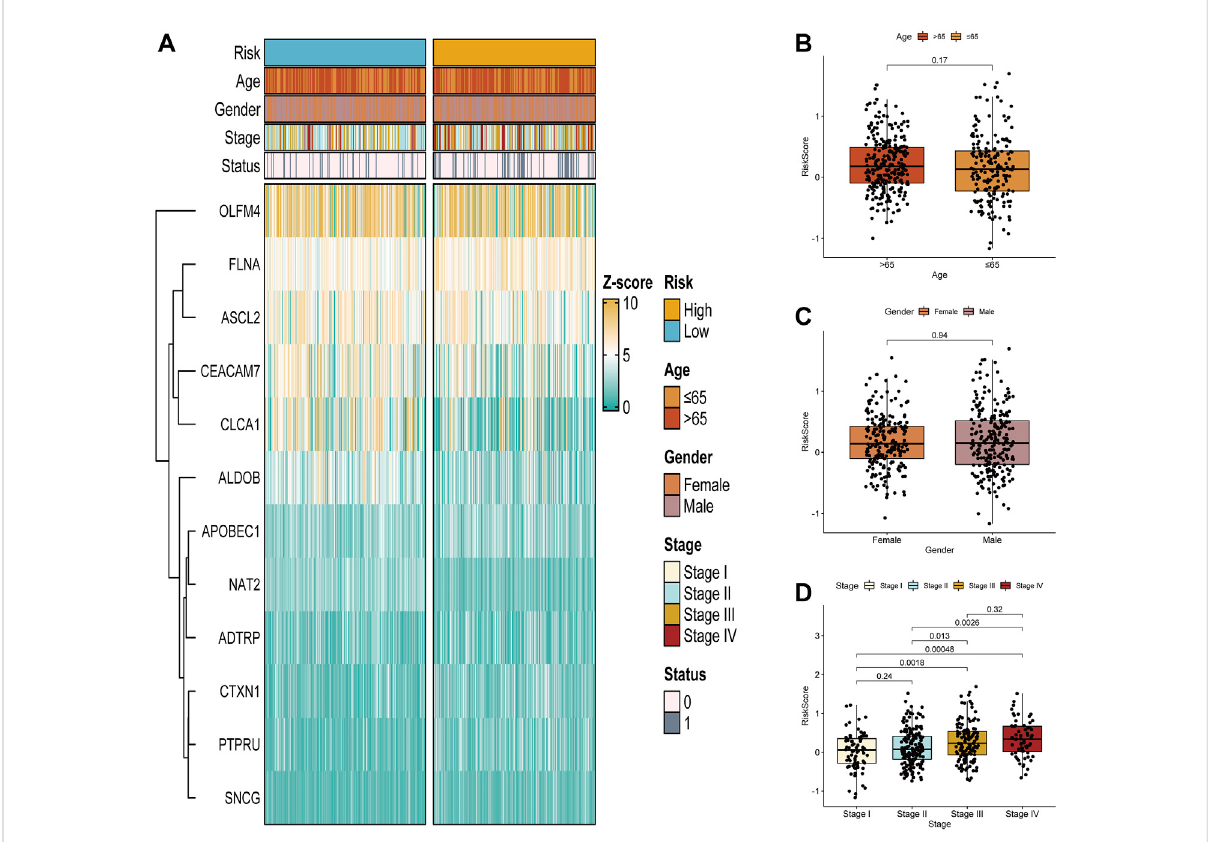
FIGURE 5 Correlationbetweentheglycolysis-andlactate-relatedgeneprognosticsignatureandclinicalcharacteristics. (A) Differencesinglycolysis-and lactate-related gene expression and clinical characteristics between the two risk groups. (B – D) Analysis of correlations between the glycolysis- and lactate-related gene signature and age (B) , gender (C) , and stage (D) .